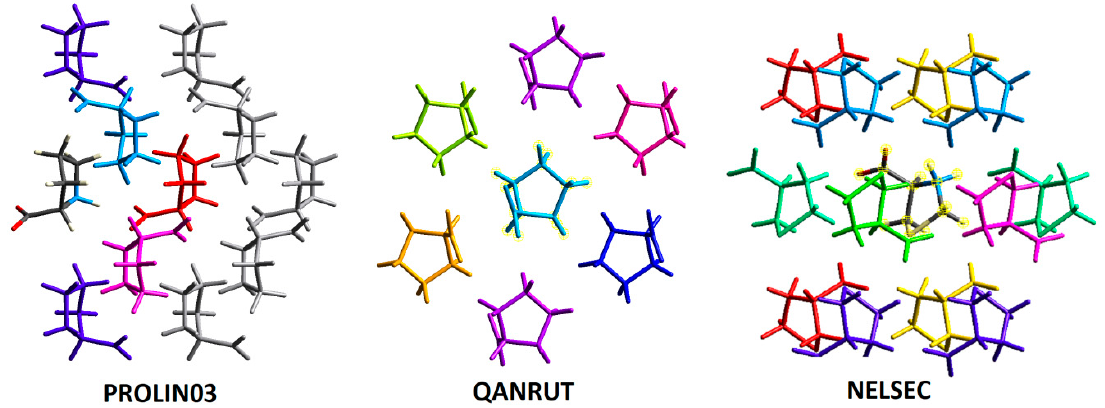
Figure 17. Color coding of neighbouring molecules in proline structures in relations to the central molecule. A view along the b -axis (for interpretation of the references to colour in this figure legend, the readers are referred to the web version of this article).